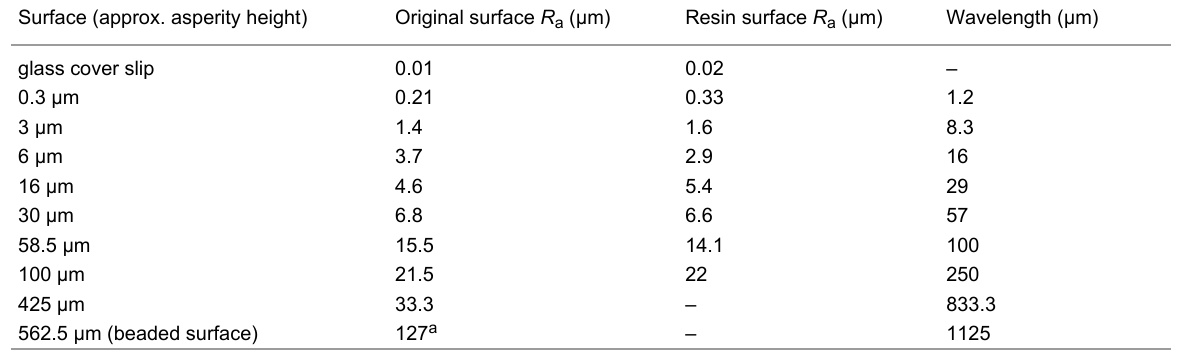
Table 1: List of average roughness values ( R a , in µm) for surfaces used in experiments (polishing discs/sandpaper and their resin copies). The wave- length (width of the asperities) was measured by viewing the surfaces under a microscope. Surface (approx. asperity